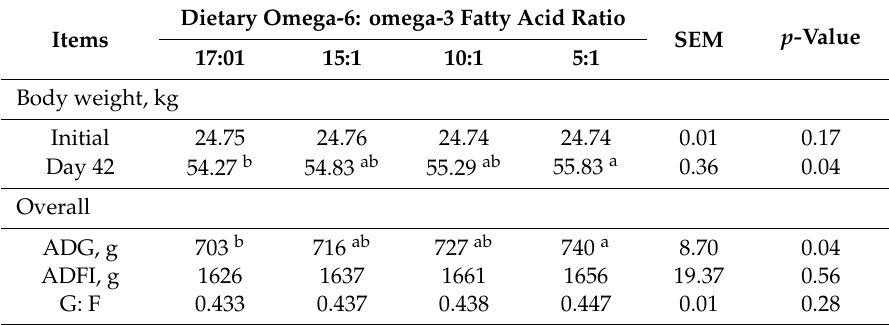
Table 3. E ff ect of omega-6: omega-3 fatty acid ratio on growth performance in growing pigs